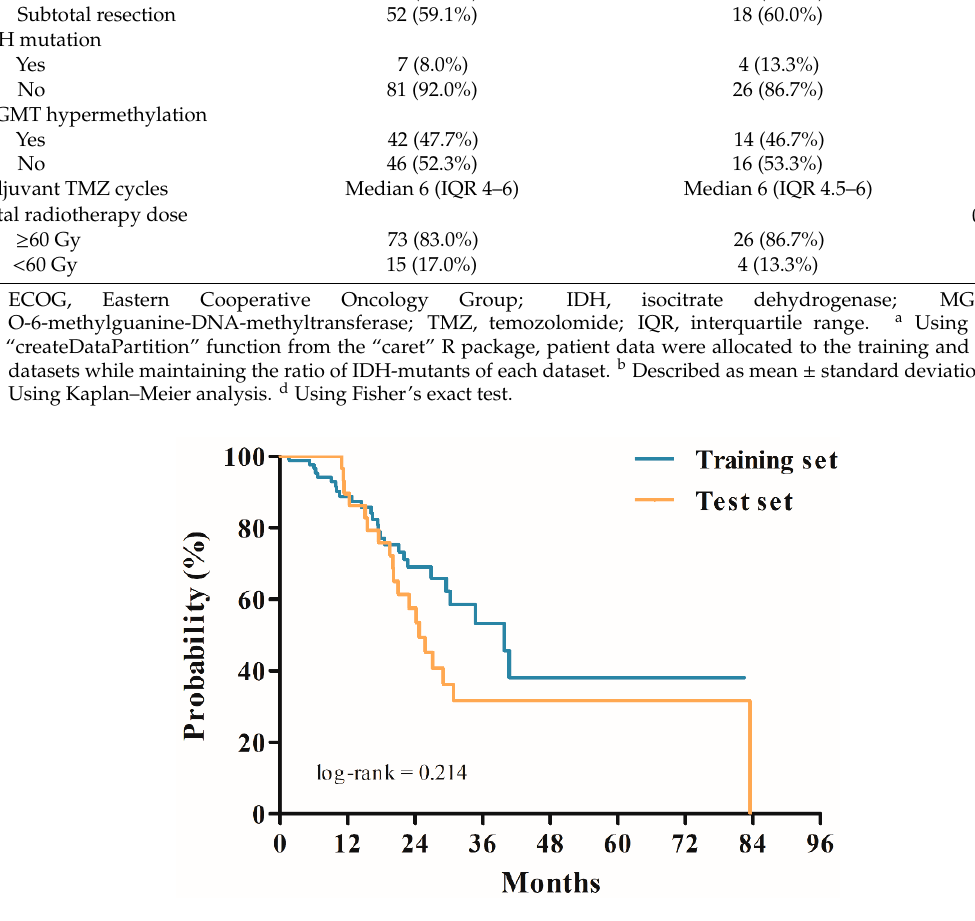
Figure 1. Kaplan–Meier survival curves for overall survival.